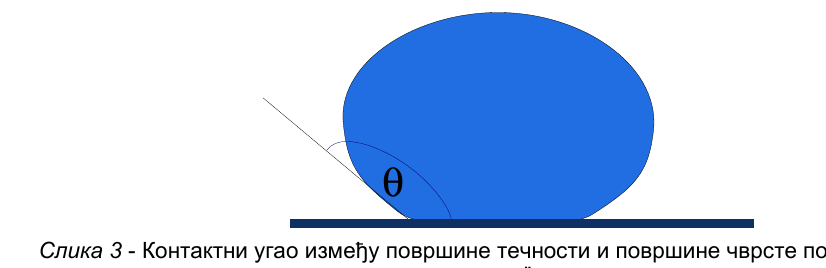
Figure 2 – The contact angle between the liquid surface and the surface of a solid substrate when the liquid "wets" the surface Рис . 2 – Угол между поверхностью жидкости и смачиваемой поверхностью пола